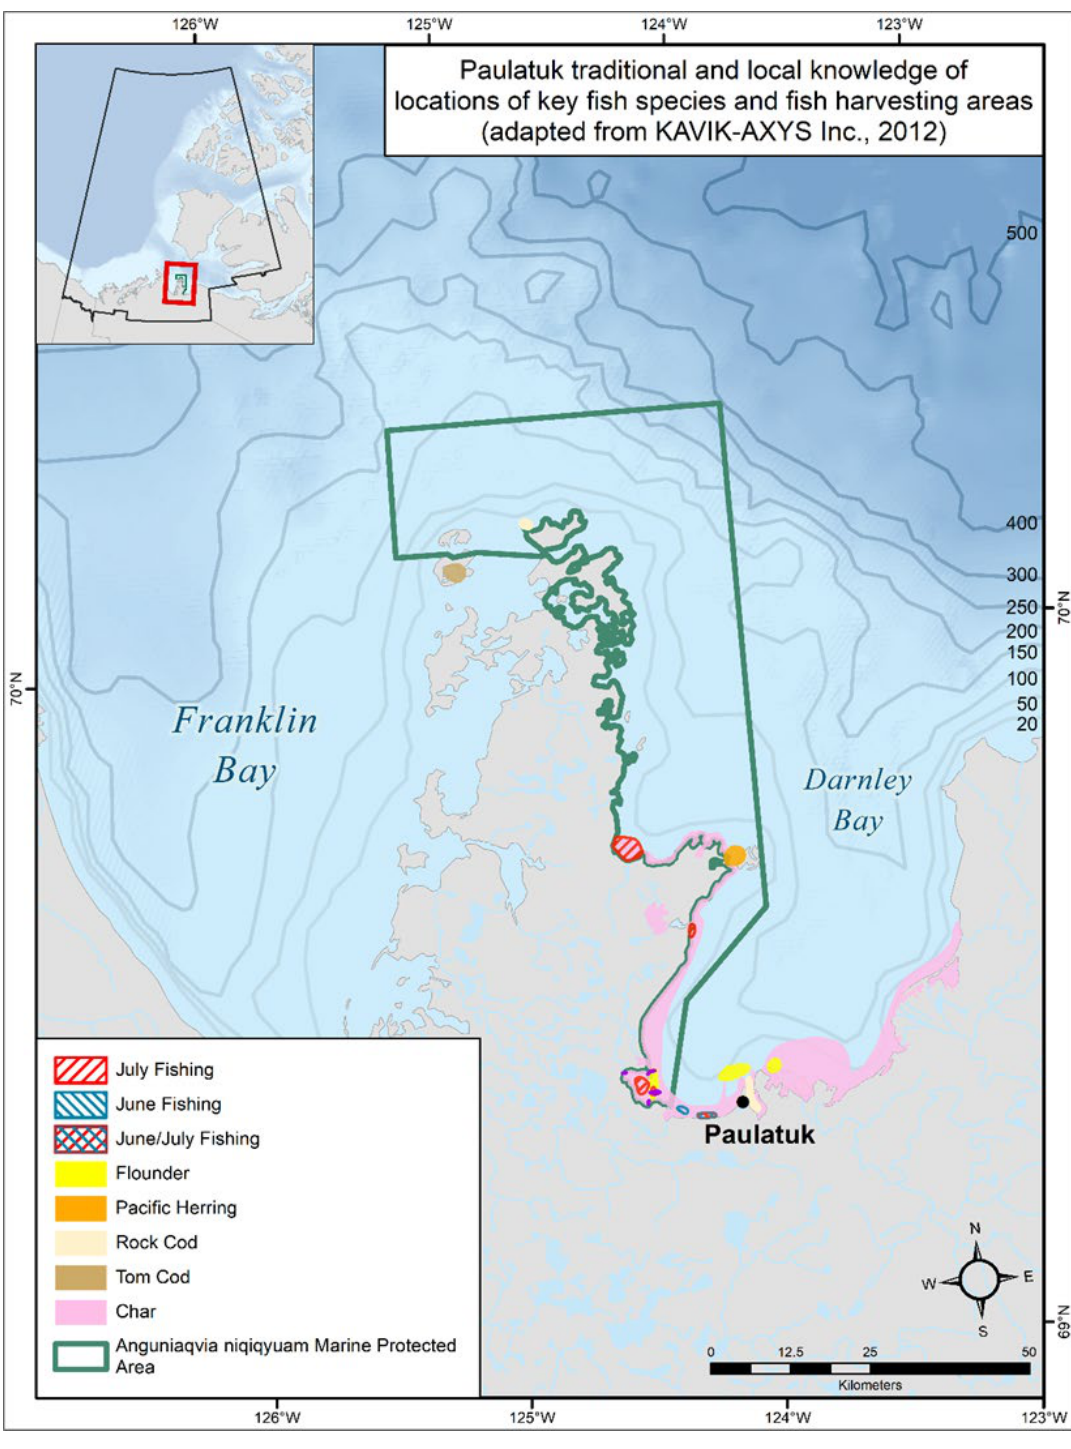
Figure 14. Locations of key fish species and fish harvesting areas in the vicinity of the ANMPA from traditional and local knowledge gathered during a workshop in Paulatuk in 2011. Map adapted from KAVIK-AXYS Inc. (2012) by J. Friesen and provided by the ANMPA Working